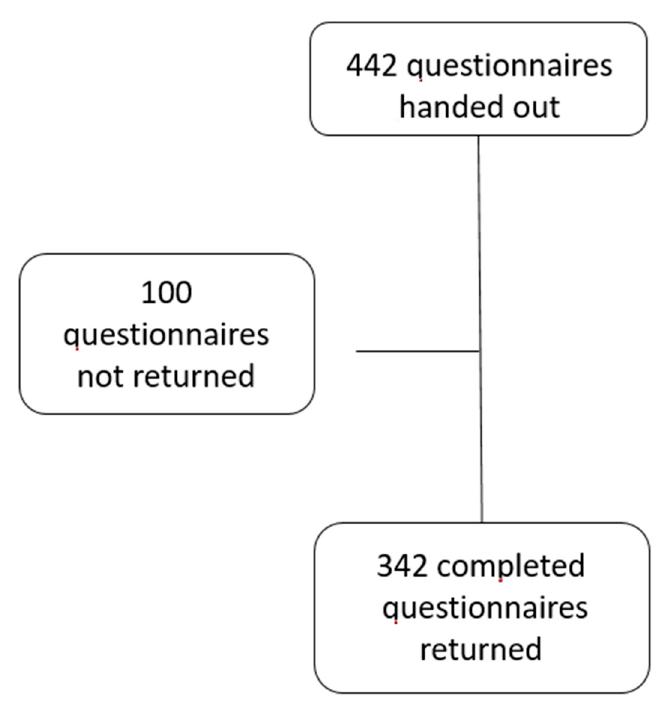
Figure 1. Flow chart of study participants.